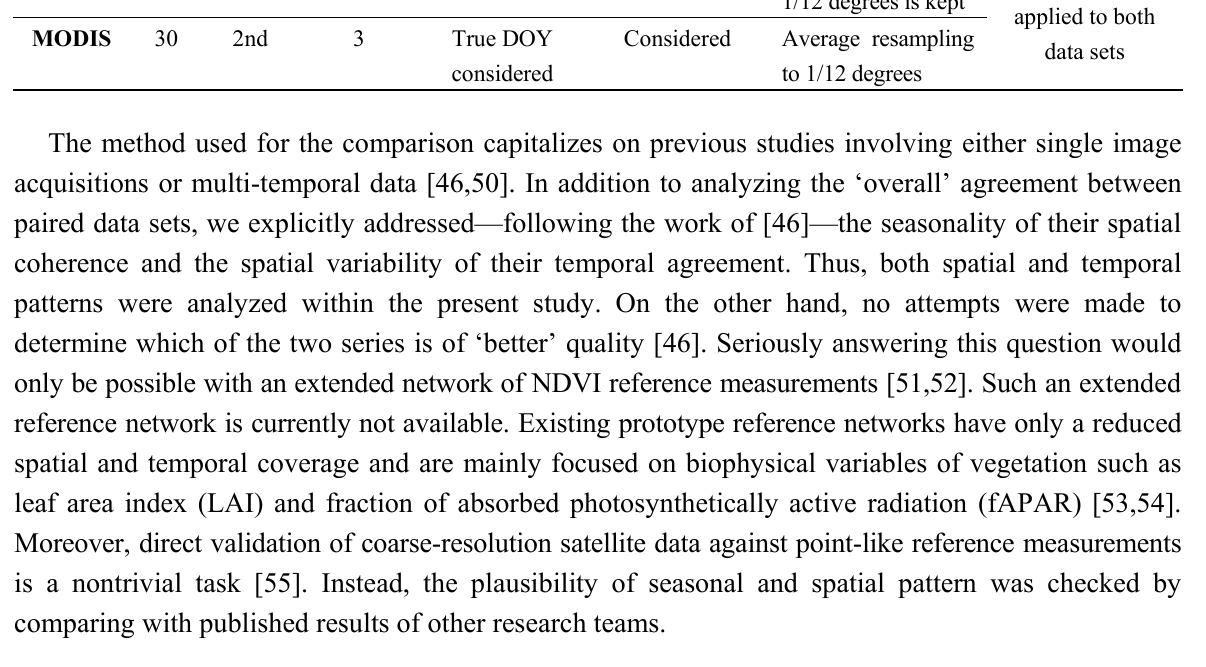
Table 2. Specification of the spatial and temporal pre-processing steps for homogenizing GIMMS and MODIS NDVI time series. The smoothing parameter ( λ ) of the Whittaker smoother determines the roughness of the smoothed curve. See text for further details. Parameterization of the Whittaker Smoother for Providing Smoothed Weekly Data λ Degree n° of Compositing Quality Spatial Land/Water × 10 3 Iterations Day Flags Resampling Masking 1 Not available Not considered Original sampling at Common masks 1/12 degrees is kept applied to both MODIS True DOY Considered Average resampling data sets considered to 1/12